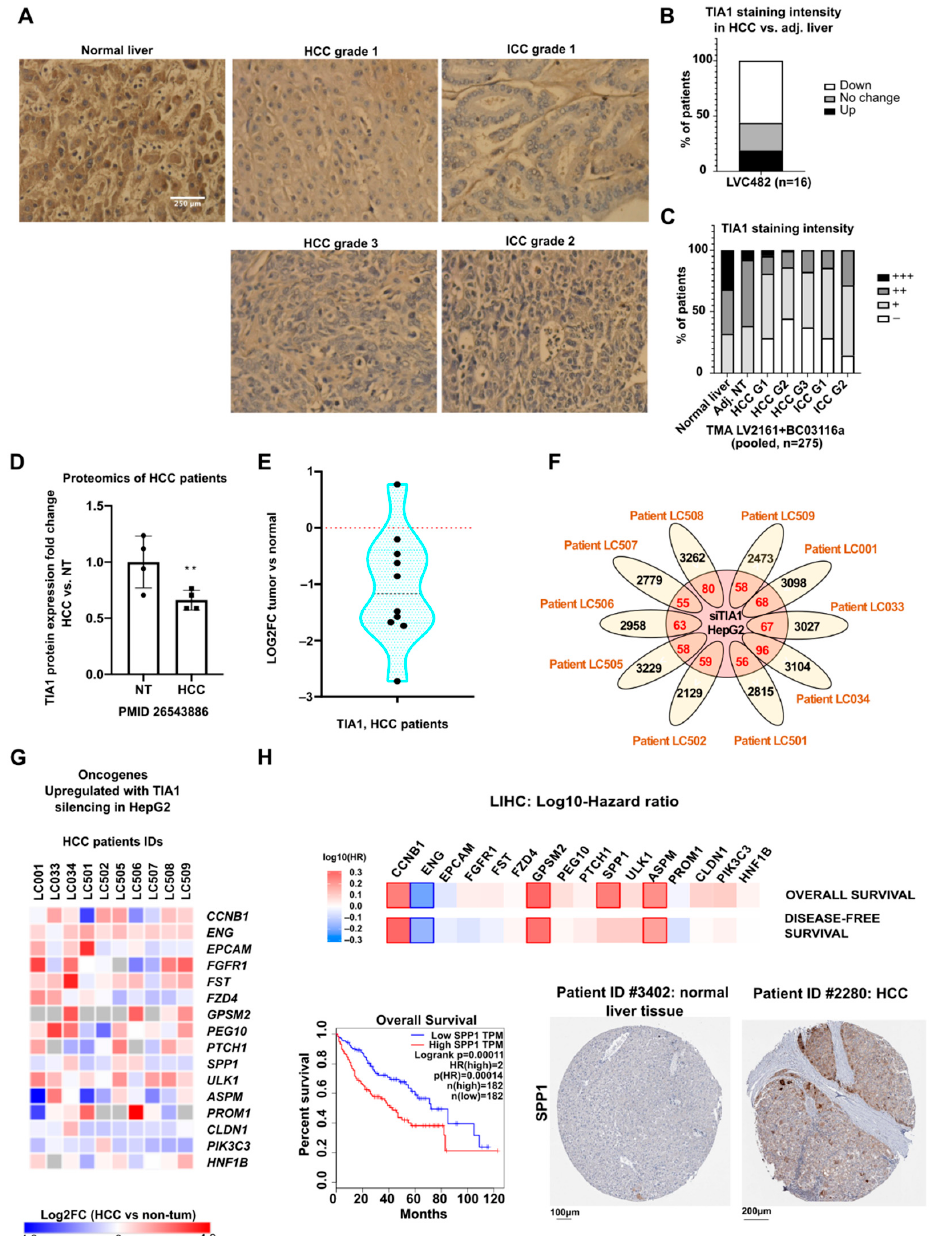
Figure 5. Expression of TIA1 and its targets are deregulated in HCC patients. ( A ) Representative pictures showing TIA1 staining in normal and tumoral liver tissues in a human tissue microarray (TMA). ( B ) Percentage of patients showing a change in TIA1 staining between non-tumoral and HCC tissues in TMA LVC482 (n = 16). ( C ) Intensity of TIA1 staining in human TMAs (n = 275). ( D ) TIA1 protein levels in a proteomic of HCC patients [34]. ( E ) TIA1 mRNA levels in a translatomic of HCC patients [35]. ( F ) Upregulated genes in the translatomic of HCC patients [35] (FC >= 1.5, tumor vs non-tumoral tissues) crossed with genes upregulated in HepG2 siTIA1 translatomics (FC >= 1.5, p < 0.01). ( G ) The expression of potential TIA1 targets in the translatomics of HCC patients. ( H ) Hazard ratio of overall and disease-free survival of patients based on mRNA levels of potential TIA1 targets (LIHC, GEPIA), and a survival curve and representative pictures of SPP1 staining in healthy and HCC livers (Human Protein Atlas). Data were represented as mean ± SD. Unpaired t-test was used for comparison of two groups, unless specified otherwise. ** p < 0.01.